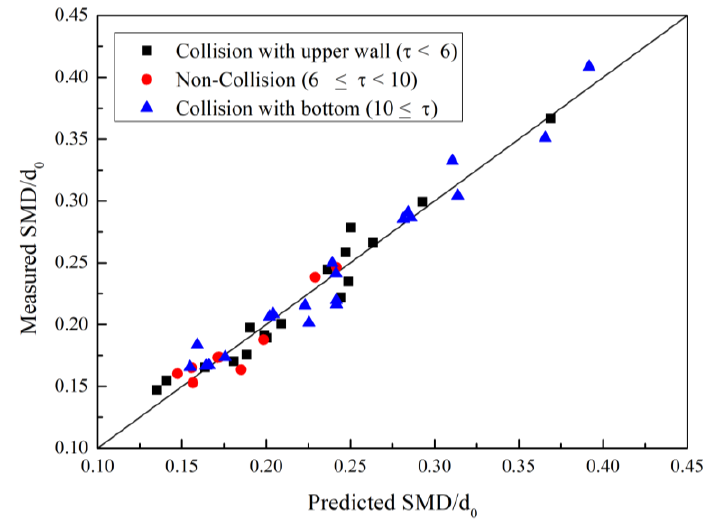
Figure 20. Comparison between the measured and predicted SMDs at three types of mechanisms.